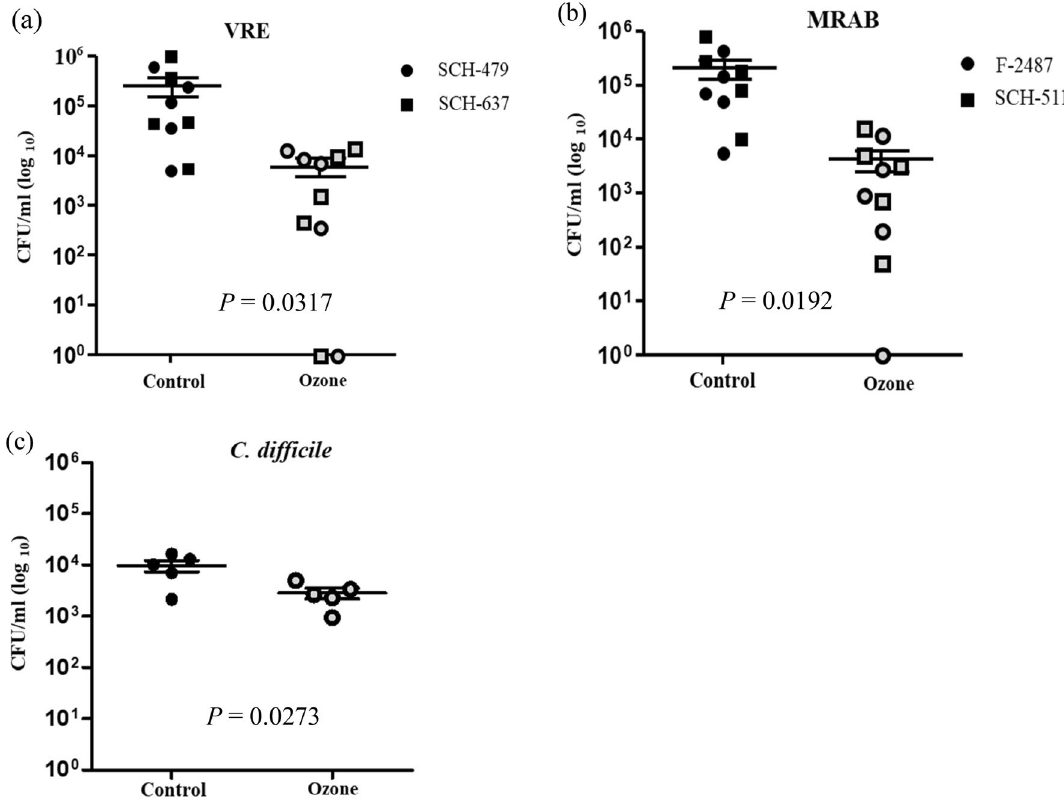
Figure 2. Scatterplot for effects of ozone on bacterial kill of ( a ) VRE, ( b ) CRAB and ( c ) C. difficile on various